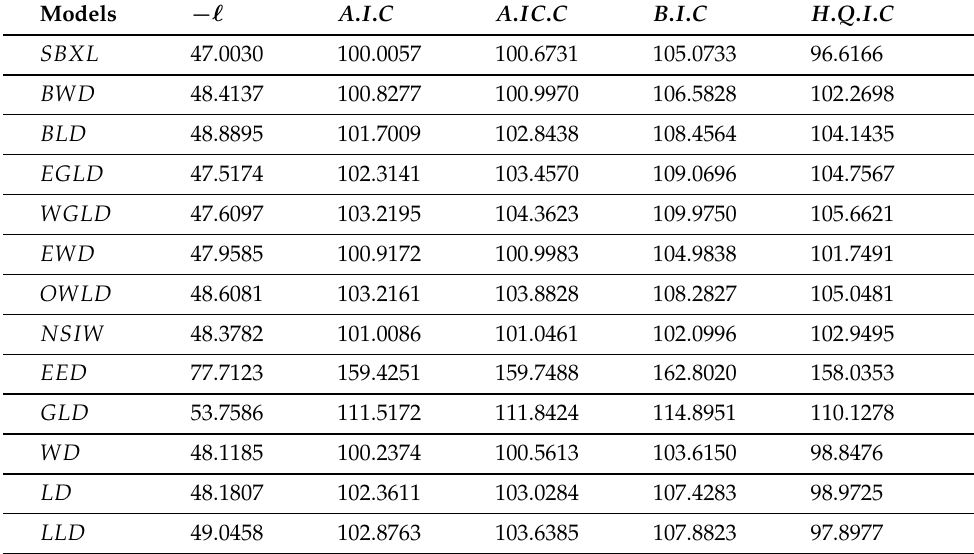
Table 8. Comparison of data set I fitting via information